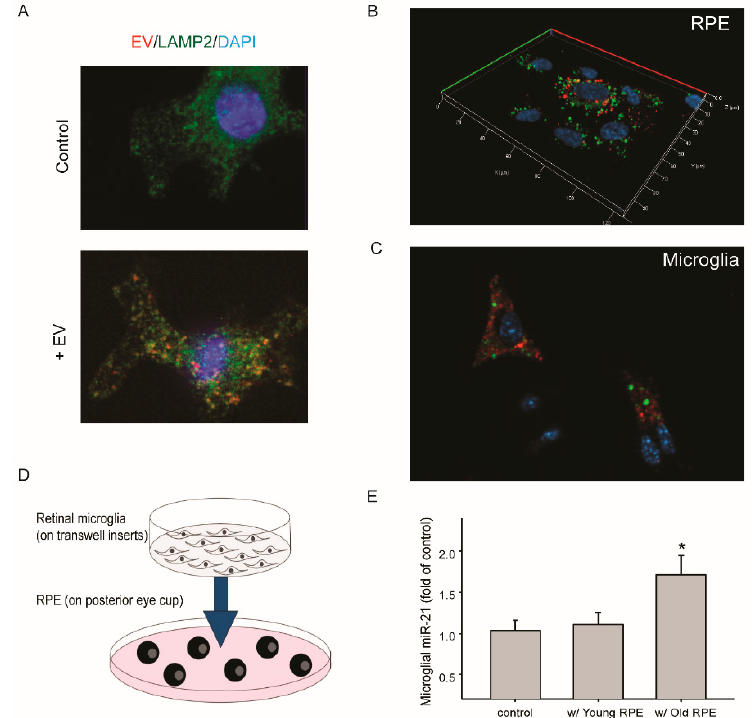
Figure 3. Transferred miR-21 between cultured RPE and microglia. ( A ) Microglial uptake of purified EVs from RPE. EVs were labeled with the lipophilic dye DiI (red). Immunostaining of LAMP2 was performed (green), along with DAPI staining of nuclei. ( B ) and ( C ) miR-21 transferred via RPE-conditioned medium. ( B ) Fluorescein-labeled miR-21 mimics (green) were transfected into cultured mouse RPE cells. ( C ) One day after transfection, the conditioned medium was collected and used to treat cultured microglia. Red: LysoTracker Red. ( D ) Schematic model of RPE and microglia co-culture. The posterior eyecups containing RPE / choroid tissues were ex vivo cultured on 6-well plate, and microglia were grown on transwell insert. ( E ) Quantitative RT-PCR analyses of miR-21 levels in microglia after being co-cultured with RPE / choroid from either young or aged mice, compared to that of the control (without RPE co-culture). Data presented are the average of 3 independent experiments (mean ± sem; * p < 0.05).